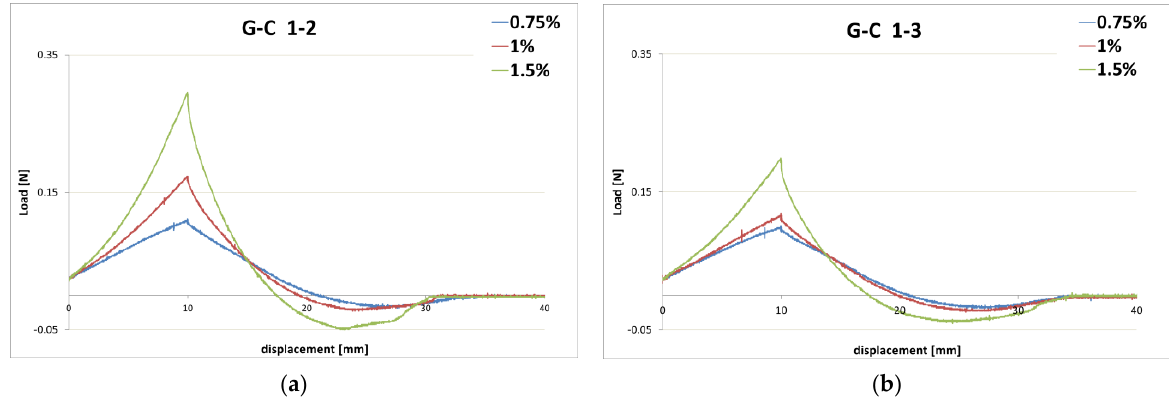
Figure 13. Texture curves obtained by an immersion/de-immersion test performed on the samples prepared with increas- ing polysaccharide total amounts (0.75%, 1%, and 1.5% w/w) at different G–C ratios: 1:2 ( a ) and 1:3 ( b